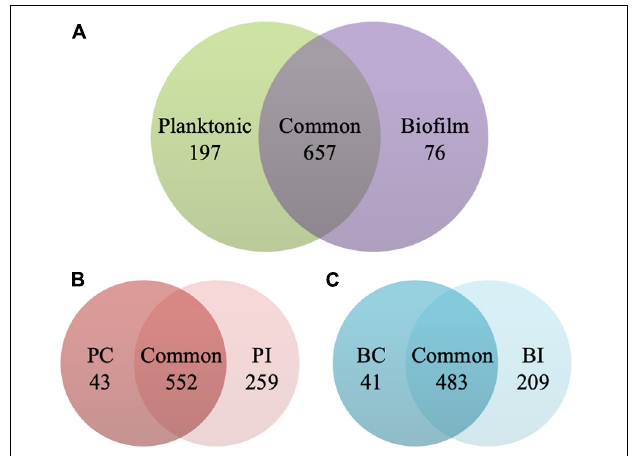
FIGURE 4 | Identification of proteins in the planktonic cells and biofilms of C. albicans . (A) Overall distribution of total protein/protein groups present in all control and CAS-treated planktonic cells and biofilms of C. albicans . (B) Distribution of proteins identified in control (PC) and CAS-treated (PI) planktonic cells of C. albicans . (C) Distribution of proteins identified in control (BC) and CAS-treated (BI) biofilms of C. albicans